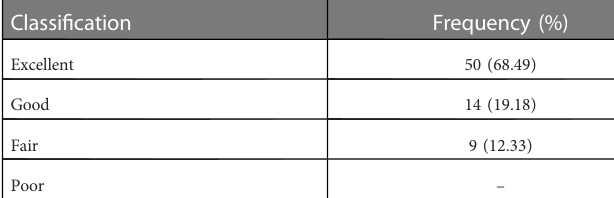
TABLE 4 Clinical outcome of surgery based on modi fi ed Macnab